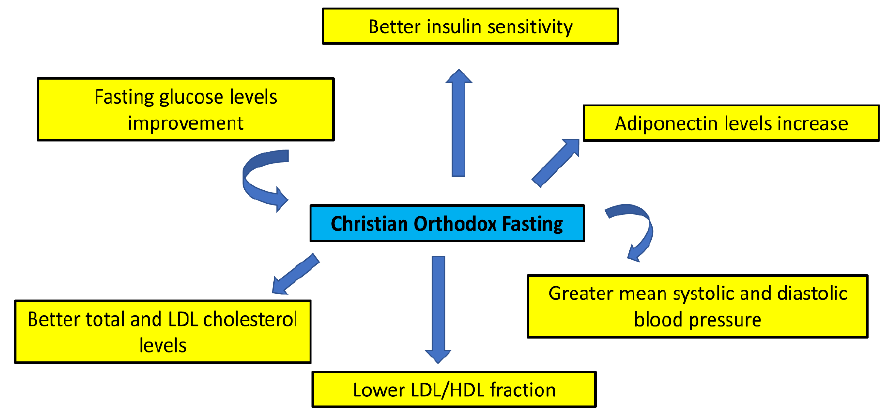
Figure 2. Potential benefit effects of Christian Orthodox fasting on cardiometabolic